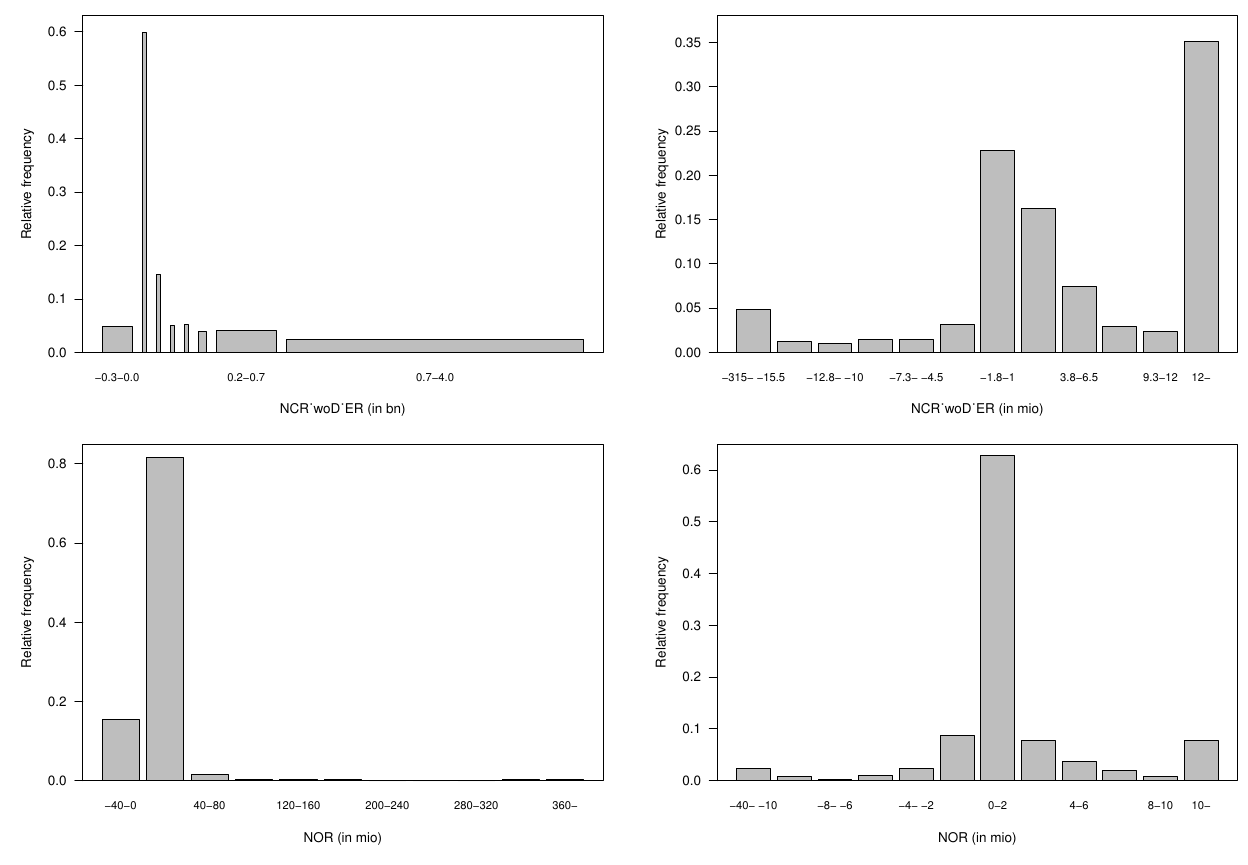
Figure A8. Relative frequency of the insurance cost for non-life undertakings: net claims pay- ments ( NPA ), net change in claim reserves without change in ER ( NCR _ woD _ ER ) and net change in other technical reserves ( NOR ). The figure presents twice the relative frequency of the NPA and NCR _ woD _ ER : once sliced by the optimal bin out of our model and once sliced by equal bands, whereby the last band includes all remaining higher observations. NOR is sliced in two different intervals.